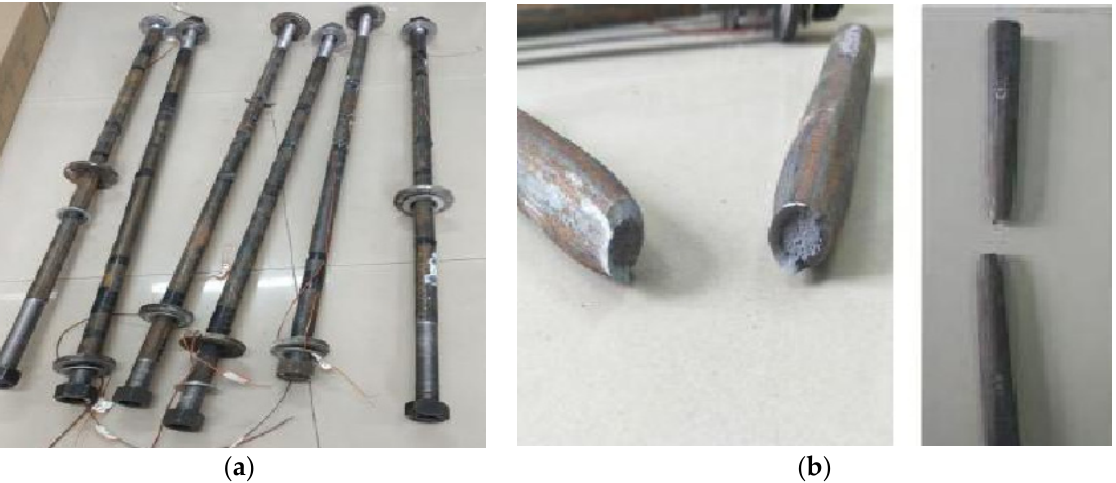
Figure 6. Tensile testing of bolt specimens. ( a ) Connection bolt; ( b ) bolt specimens damaged by ten- sion. Table 5. Mechanical properties of bolts. Bolt Grade